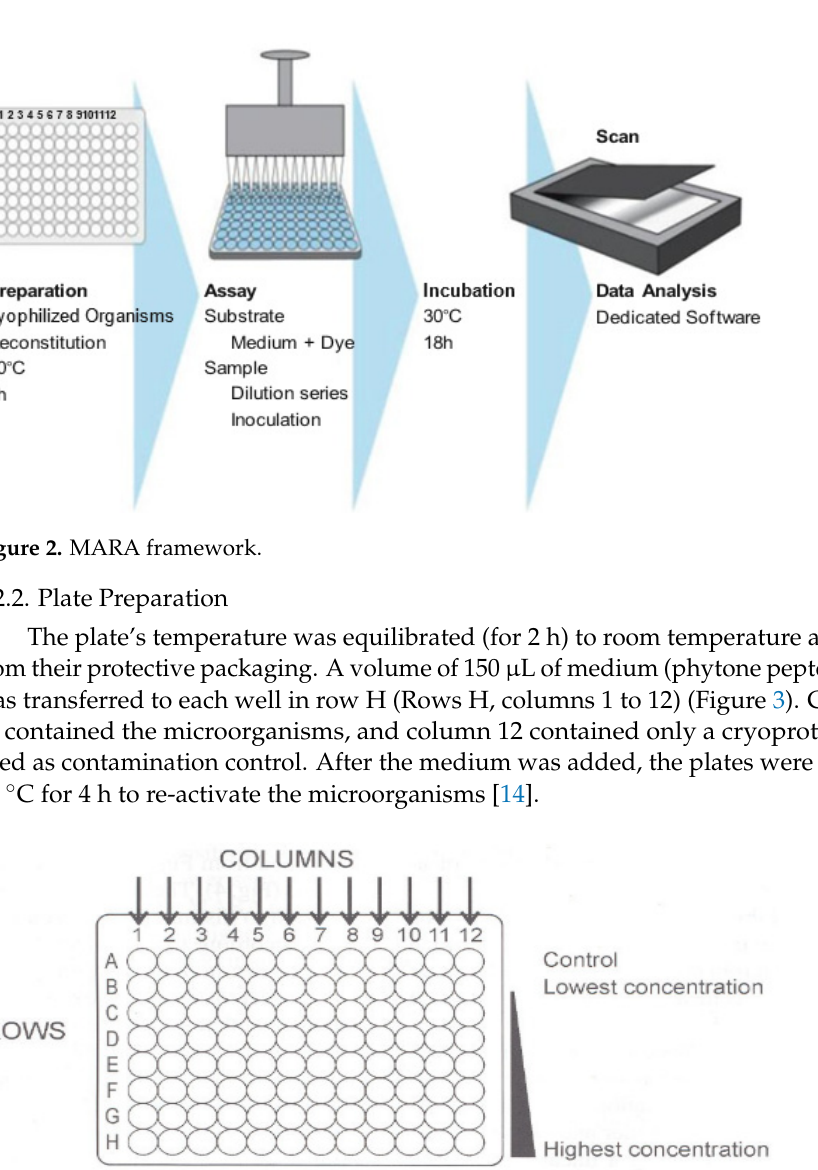
Figure 2. MARA framework .